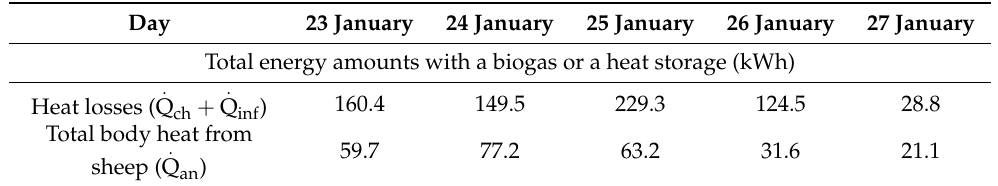
Table 7. Sheep barn energy analysis for the two settings when the windows were closed during the operation of the automated